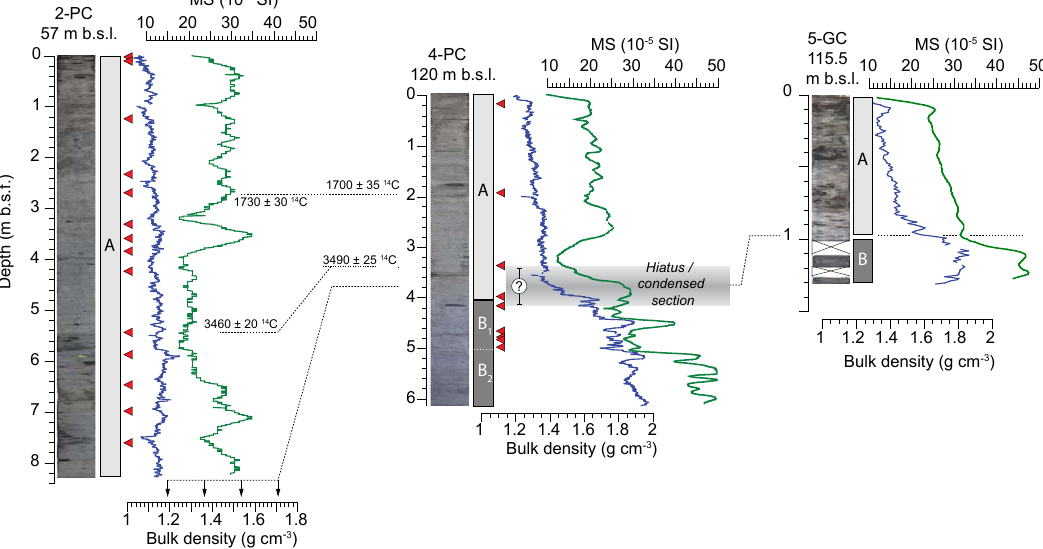
Figure 2. Transect of Herald Canyon cores SWERUS-L2-2-PC1, 4-PC1, and 5-GC showing core photographs, lithologic units A and B, radiocarbon age control (red diamonds), magnetic susceptibility, and bulk density. Further details on the age model of core 2-PC1 can be found in Pearce et al. (2017), and additional details on the lithology of 2-PC and 4-PC are in Jakobsson et al. (2017).